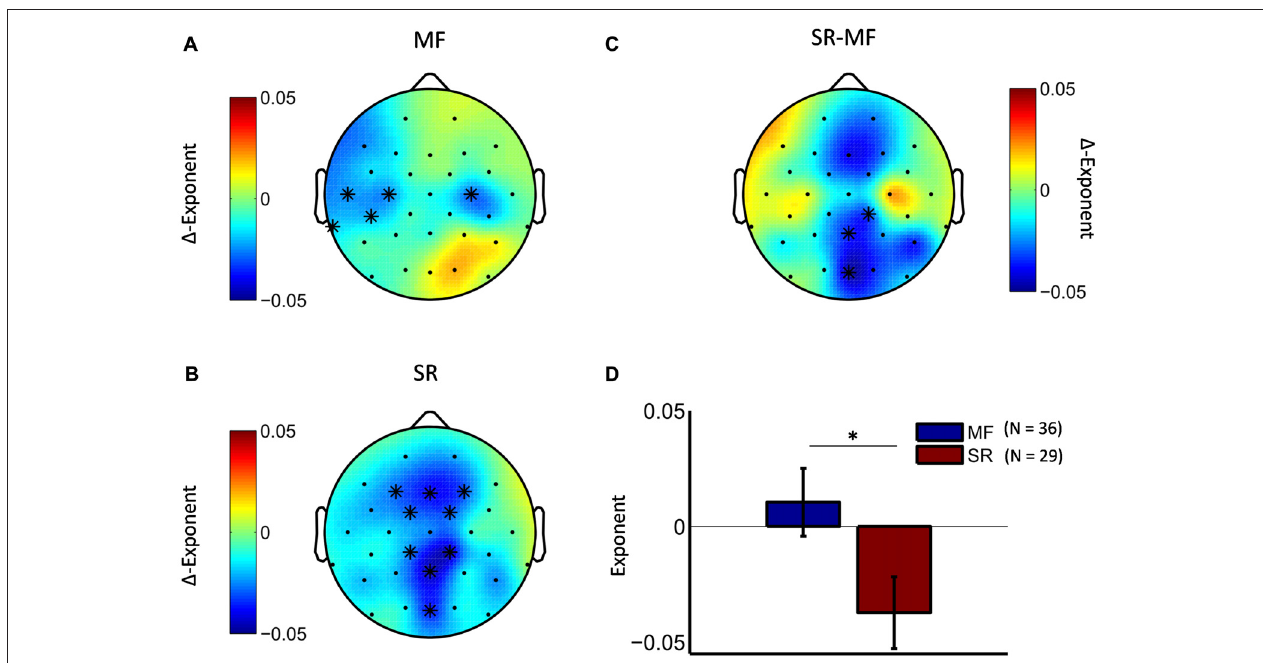
FIGURE 4 | Mindfulness training and stress-reduction differentially affect the topography of LRTC in theta oscillations. The difference topography in the mindfulness group (A) and the stress reduction group (B) shows distinct topographic patterns (significant pre-post differences are marked with a star). Direct comparison of the two groups revealed a marginally significant cluster (C) , which was located at posterior midline electrodes (cluster-electrodes are marked with a star). (D) Mean ∆ -exponent values at a central cluster-electrode (Oz, t -statistic, ∗ p < 0.05).